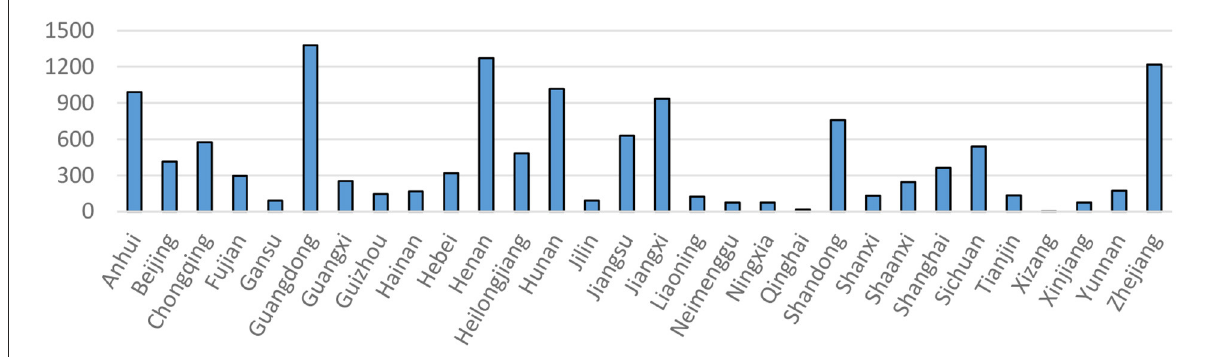
FIGURE1 The cumulative number of confirmed cases of COVID-19 by region (as of March 18, 2020). Source: CSMAR database; China Social Quality Foundation database.